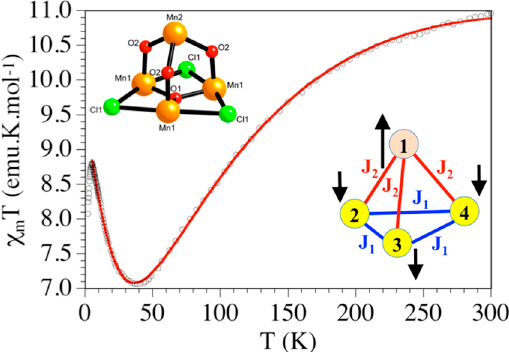
Figure 4. χ m T (per Mn 4 cluster) vs. T plot for compound 1 . Solid line indicates the best fit to the tetramer model (see text). Inset shows exchange scheme of the Mn 4 cluster.